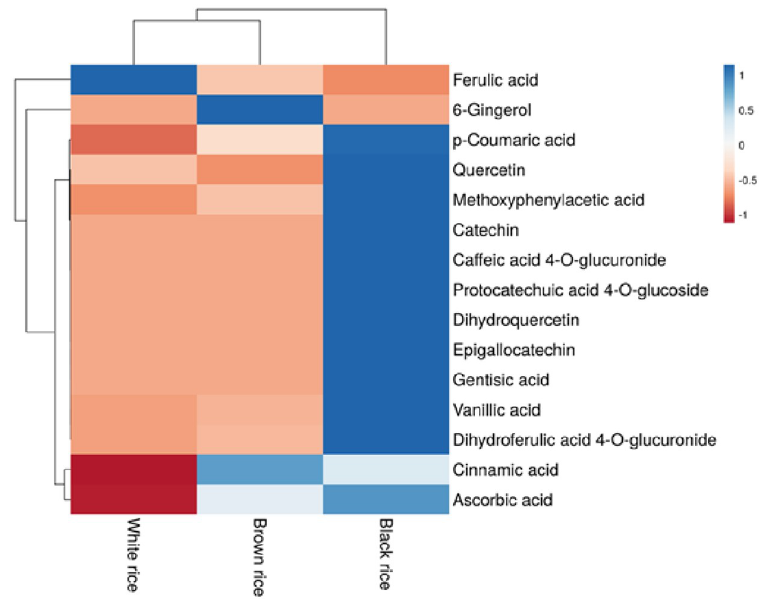
Fig 3. Heat map showing levels of phytochemicals in different pigmented and non-pigmented rice (white, brown, and black) extracts.